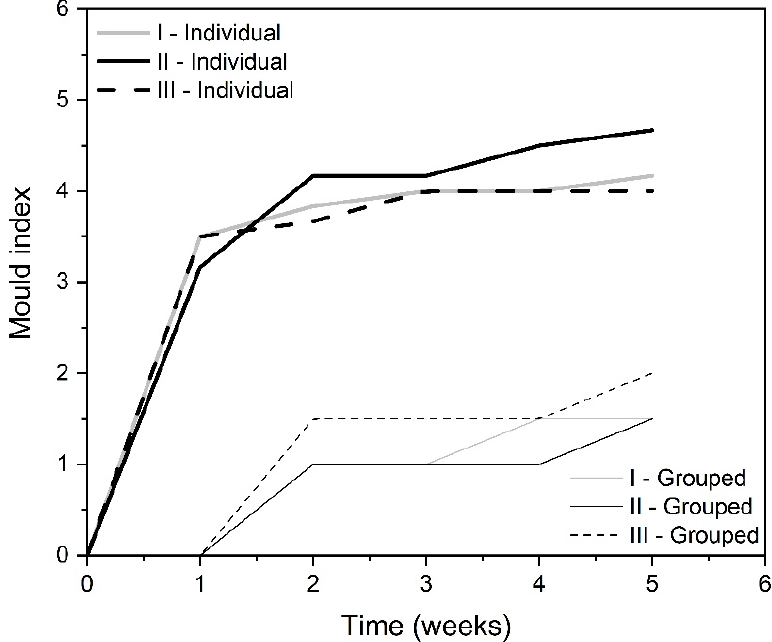
Figure 12. Mould index as a function of the time for individual and grouped giant reeds.